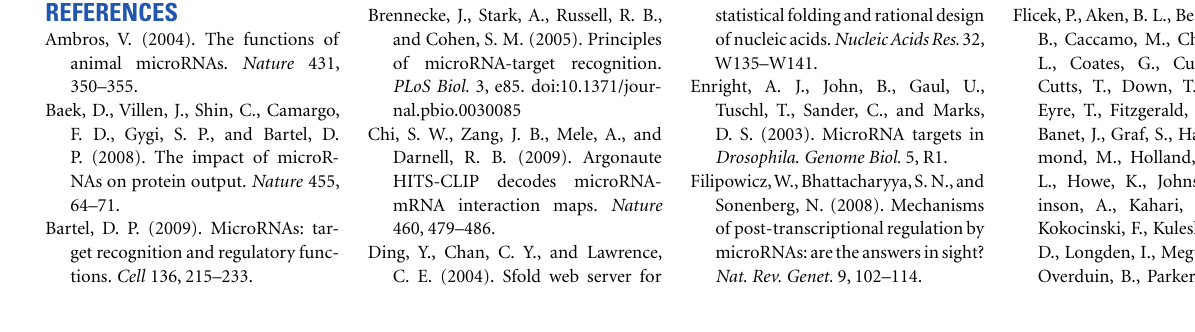
FIGURE 7 | Integration of DIANA-microT-ANN and DIANA-mirPath. The functional filtering performed by DIANA-mirPath produces much smaller, functionally related, subsets of miTGs.The visualization of the miTG subsets in the pathway maps provides a direct indication of the overall influence of the miRNA in the pathway. Each set of genes predicted as targeted for a single miRNA are analyzed with DIANA-mirPath and the results are integrated in the DIANA-microT-ANN web server to illustrate